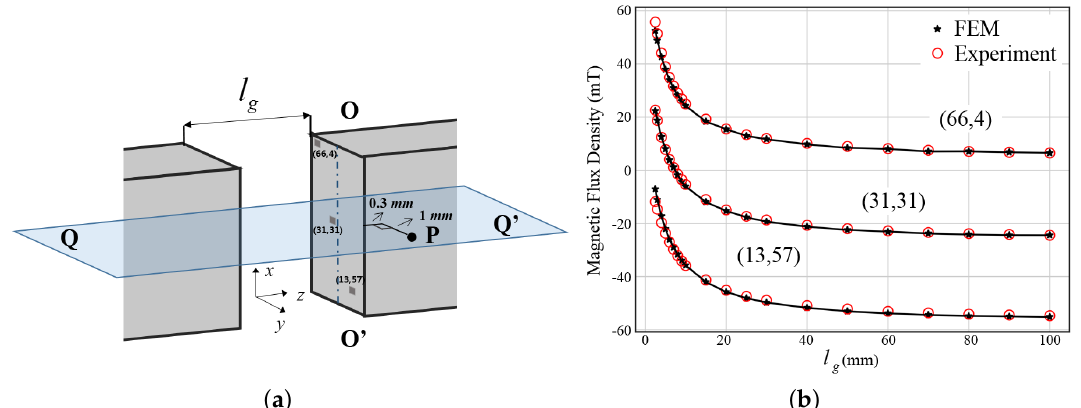
Figure 3. ( a ) Illustration of cross-section and air gap region of U-shaped cores; ( b ) Simulated B g and measured B g of location ( 66,4 ) , ( 31,31 ) and ( 13,57 ) under different air gap distances. For clarity, each curve is offset from the one above by − 30